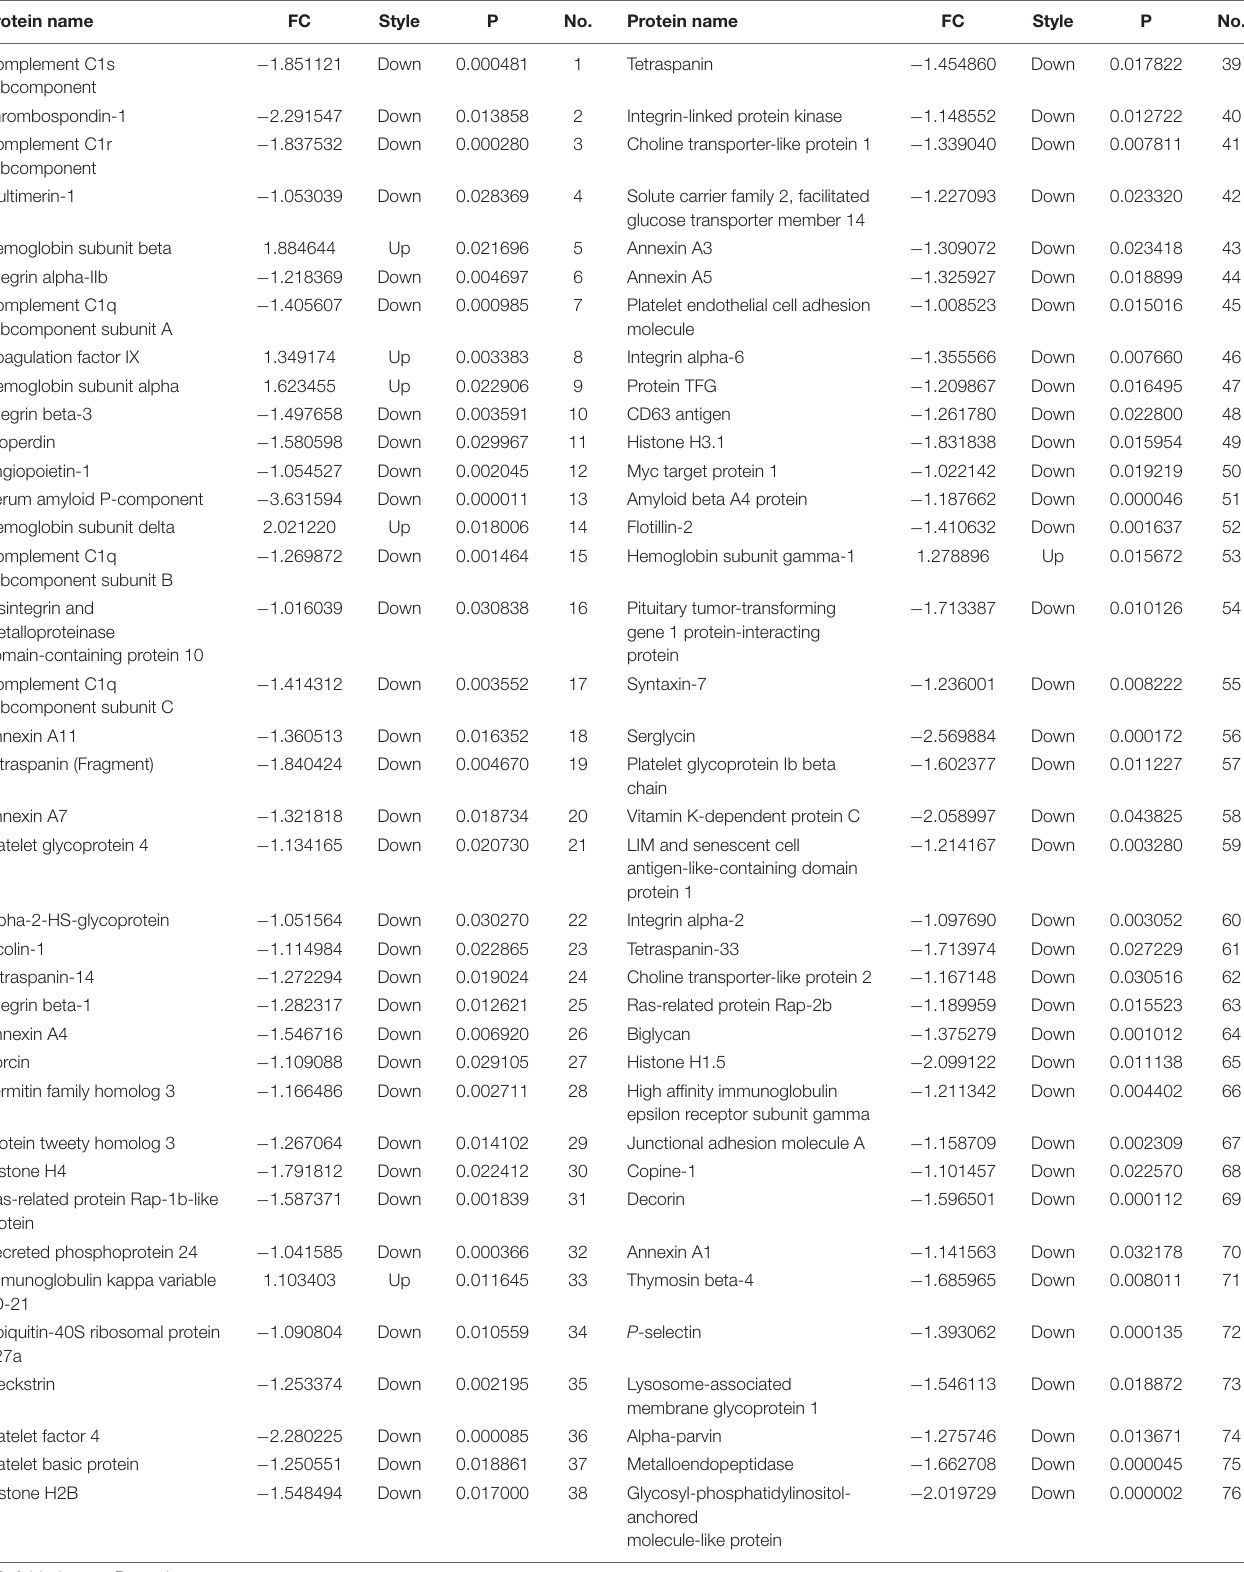
TABLE 3 | Seventy-six proteins were differentially expressed between epilepsy patients and healthy controls. Protein